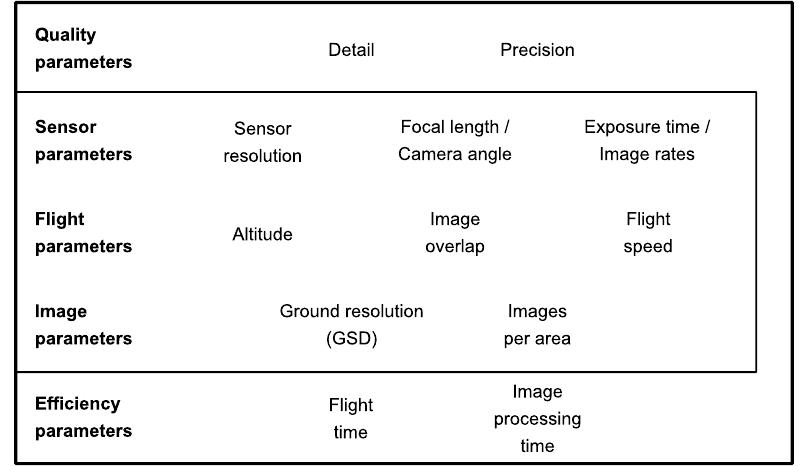
Figure 1. Different parameters in drone flights. The outer box represents the target variables, while the inner box shows the parameters that can be directly influenced by the mission planner and derivatives of those